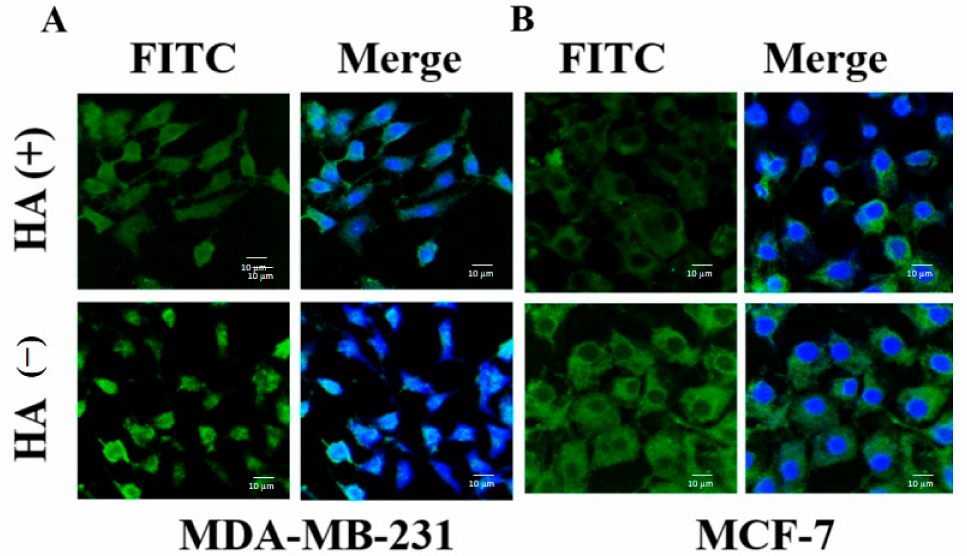
Figure 11. Confocal laser scanning microscopy (CLSM) images of ( A ) MDA-MB-231 cells incubated with FITC-labeled HA − PTX + RTV − NMF in the presence (+) and absence ( − ) of excess HA and ( B ) MCF-7 cells incubated with FITC-labeled HA − PTX + RTV − NMF in the presence (+) and absence ( − ) of excess